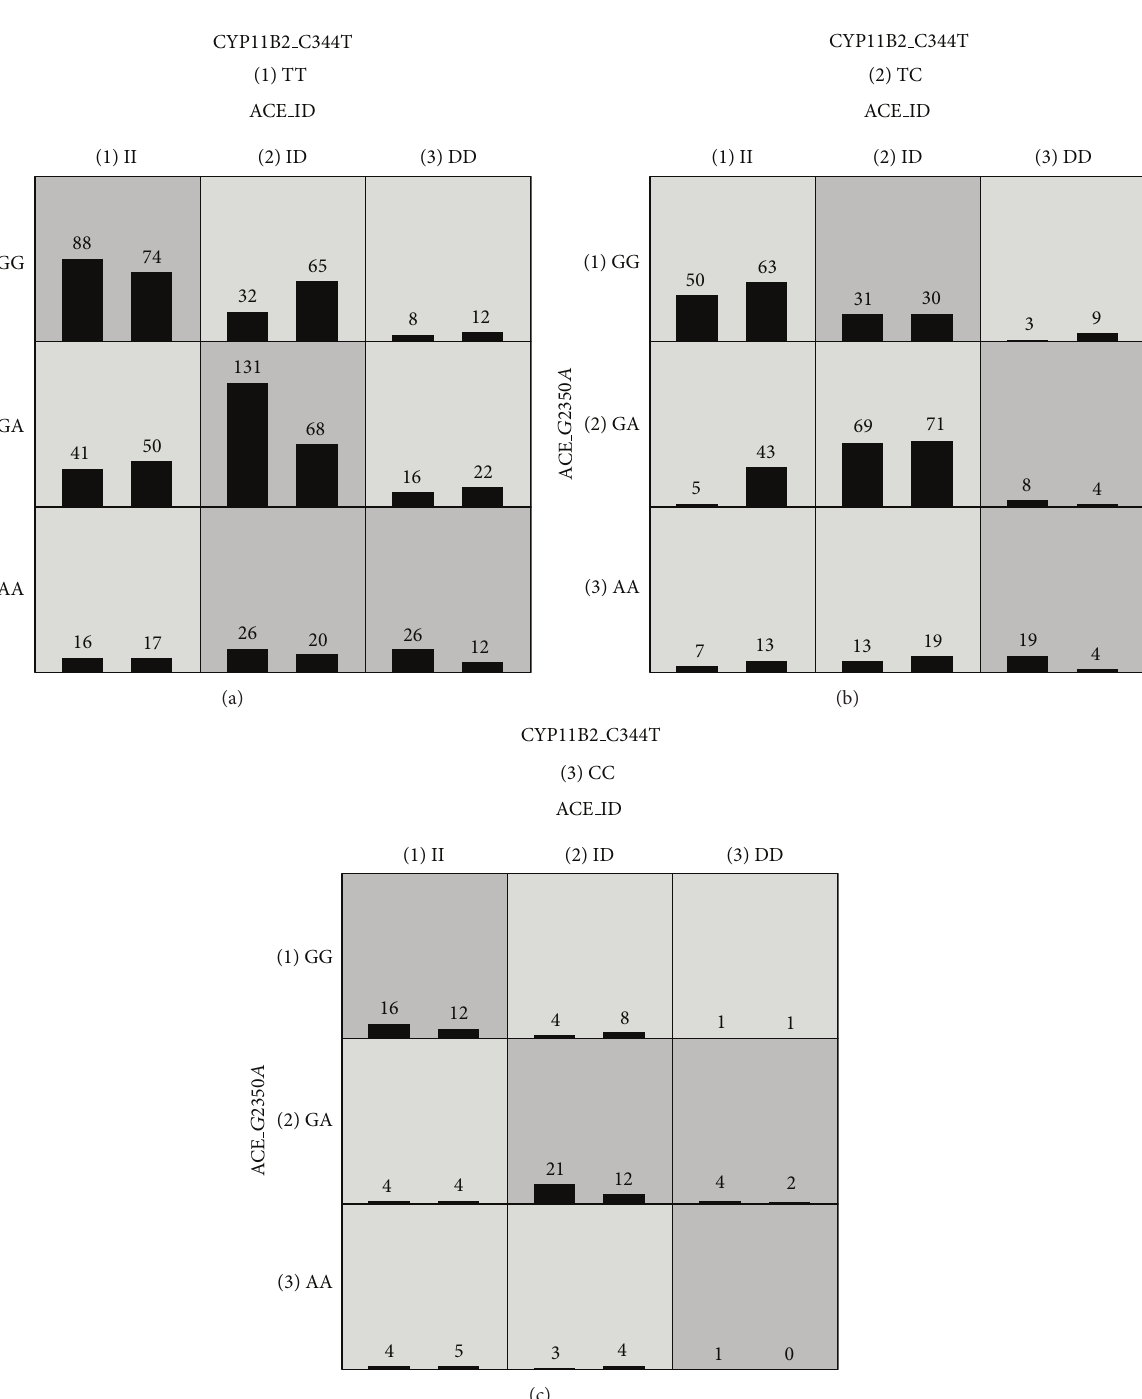
G2350A, and CYP11B2 C-344T. However, this interaction